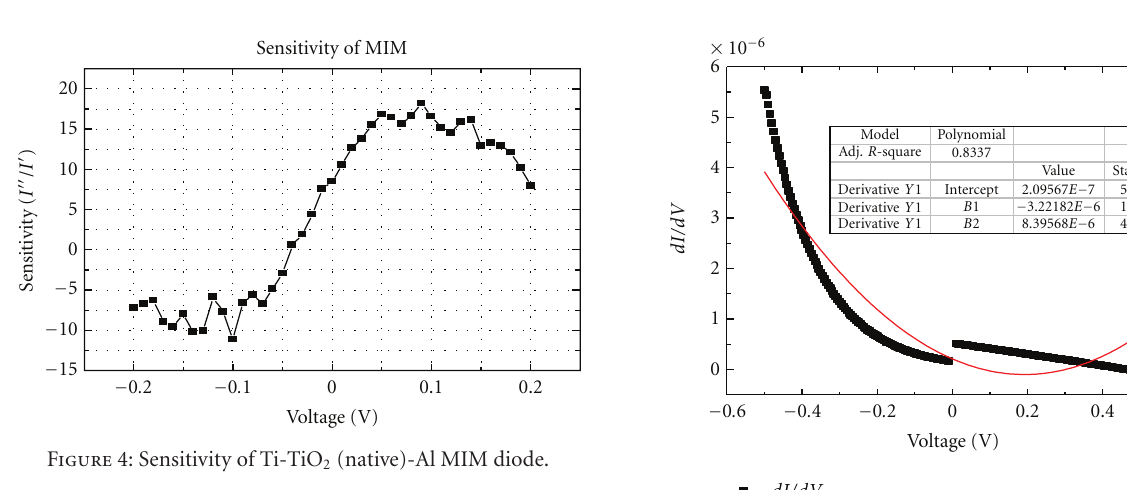
rectification ratio of the diode which is 15 at 0.495 V for plasma oxide, is more than reported in previous works. The rectification ratio for the native oxide is observed to be 6.5 at 0.33 V. The plot for the rectification ratio is shown in Figures 7(a) and 7(b).